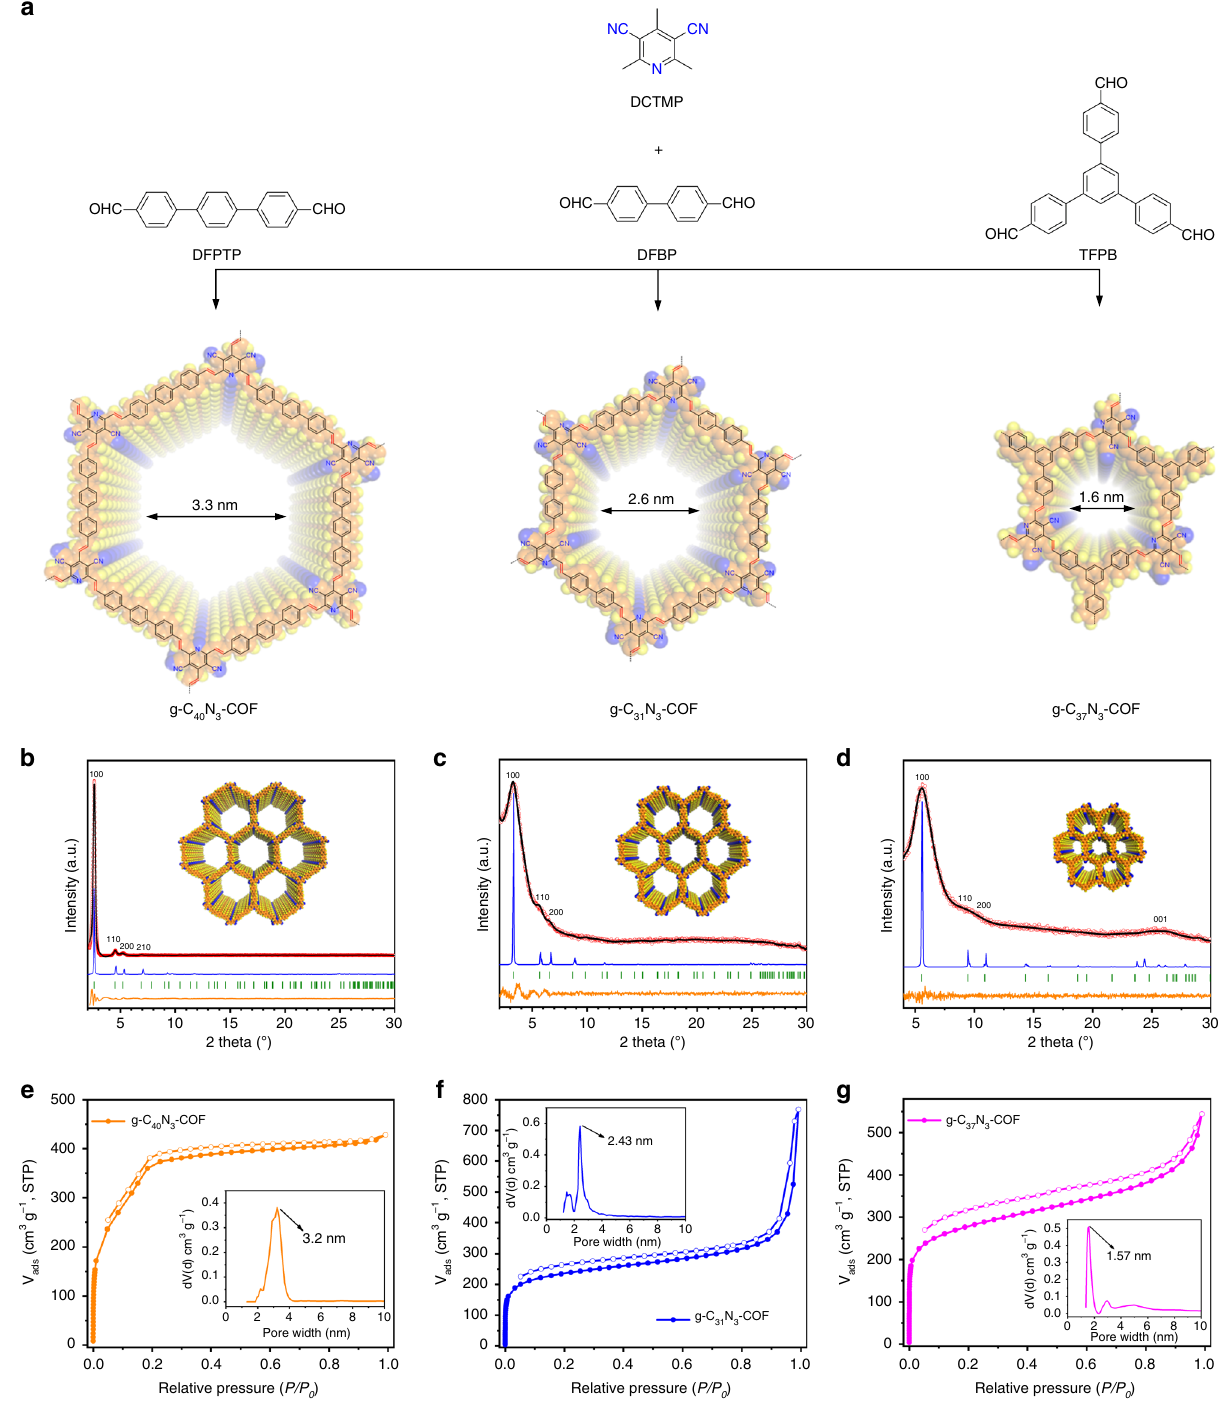
Fig. 2 Characterizations of crystal and porous structures for g-C x N y -COFs. a Illustration of synthetic procedures of g-C x N y -COFs. b , c and d PXRD patterns for g-C 40 N 3 -COF, g-C 31 N 3 -COF, and g-C 37 N 3 -COF: comparison between the experimental (red circle) and Pawley re fi ned (black) pro fi les, the simulated patterns for eclipsed AA stacking mode (blue), the Bragg positions (green) and the re fi nement differences (orange). Insets: the crystal structures of corresponding g-C x N y -COFs assuming the eclipsed stacking viewed along [001] directions. e , f and g Nitrogen adsorption and desorption isotherms of g-C 40 N 3 -COF, g-C 31 N 3 -COF, and g-C 37 N 3 -COF. Insets: the pore size distributions calculated from non-local density functional characterizations of g-C 31 N 3 -COF and g-C 37 N 3 -COF were also are depicted in Fig. 4a, revealing an ordered alignment with a high systematically performed for the veri fi cation of their chemical degree of crystallinity. A honeycomb-like porous structure was structures (Supplementary Figs. 1 – 6). clearly visualized along the [001] plane under high resolution HRTEM was used to further con fi rm the formation of a (Fig. 4b). As indicated by a fast Fourier transform (inset in Fig. 4a) periodic porous framework for g-C 40 N 3 -COF. The lattice fringes conducted on a selected area (red square in Fig. 4a), a hexagonal